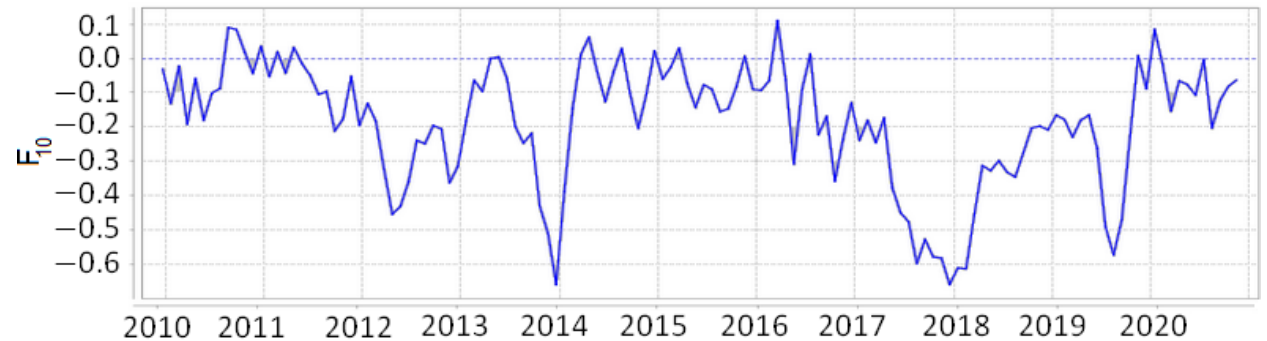
Figure 15. California. The time series of field F 10 at point 39.49 ◦ N and 123.2 ◦